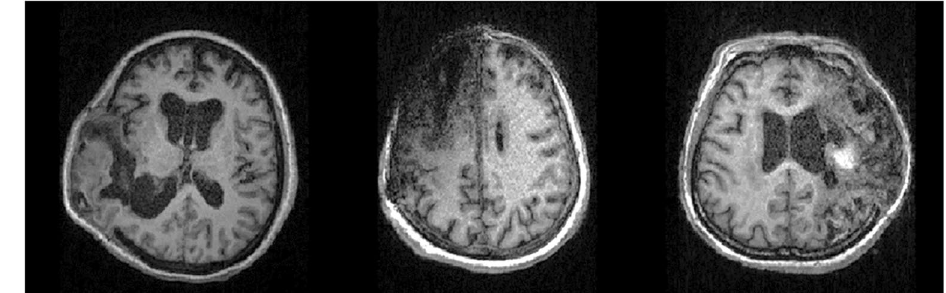
Table 1 Demographic and clinical information of all the recruited patients with secondary mild hydrocephalus Category Favorable Unfavorable p value Age (year): mean ±